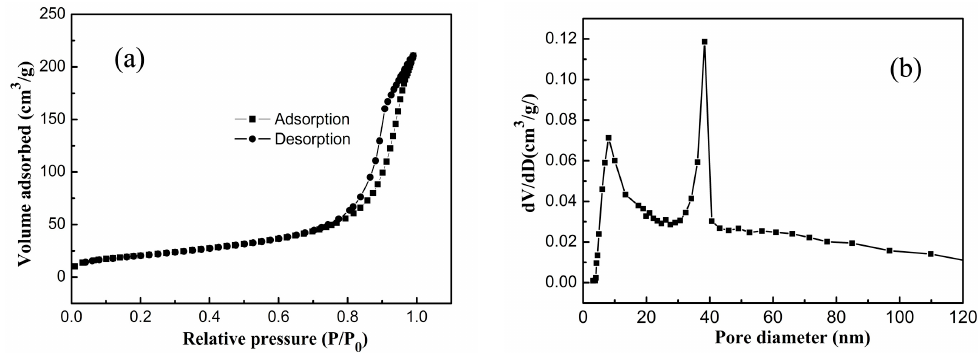
Figure 5. ( a ) Nitrogen adsorption–desorption isotherm; and ( b ) the corresponding pore size distribution of the BS-2# sample.